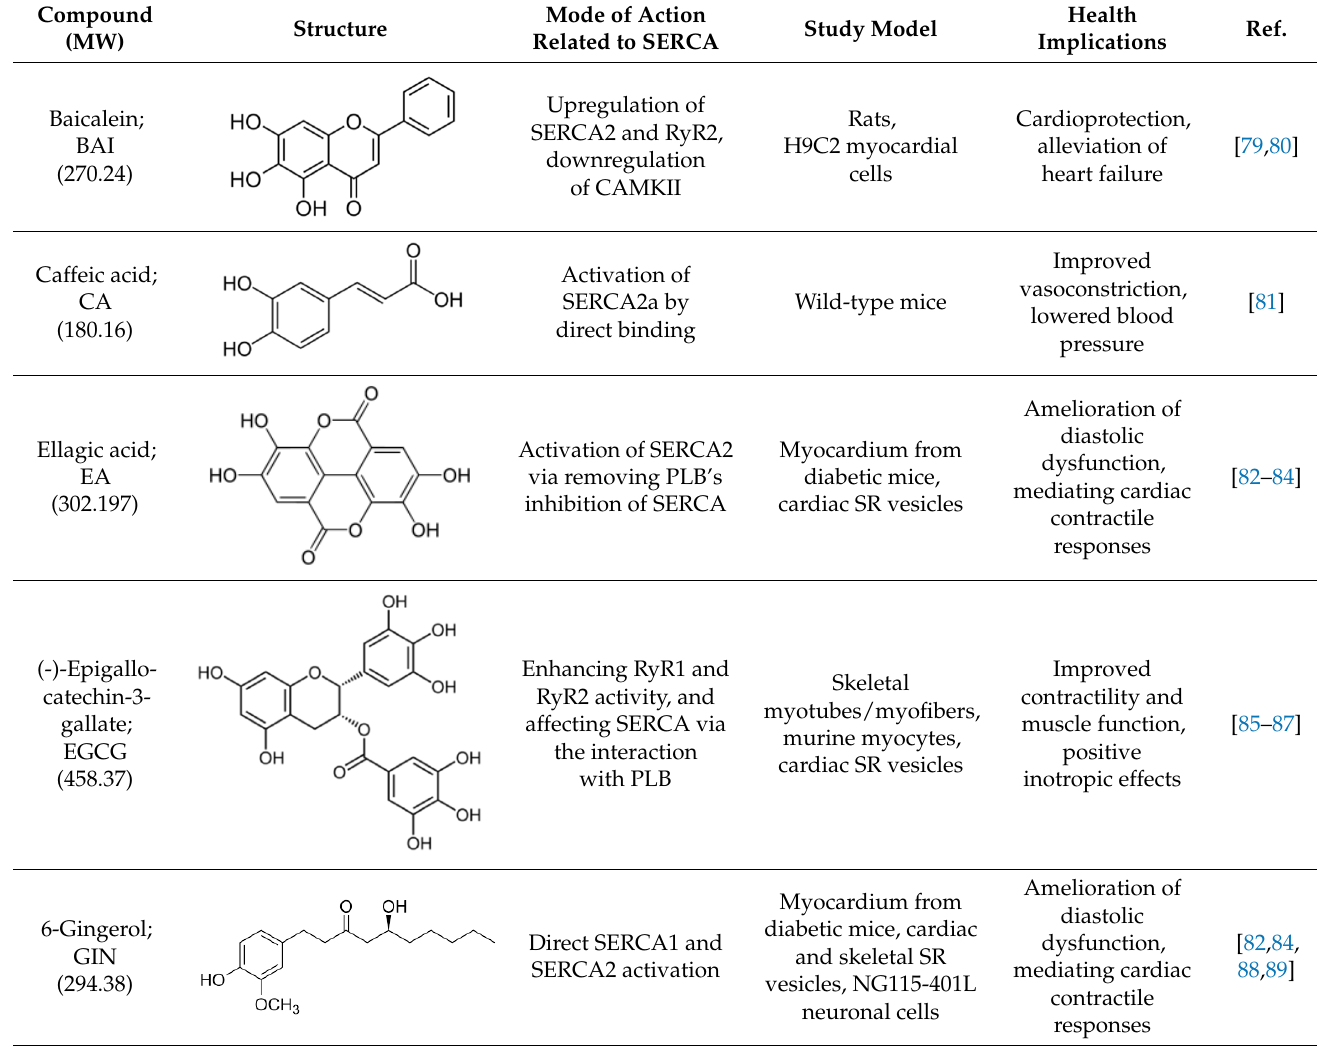
Table 2. The most important mechanisms of action of natural polyphenols related to SERCA activation.